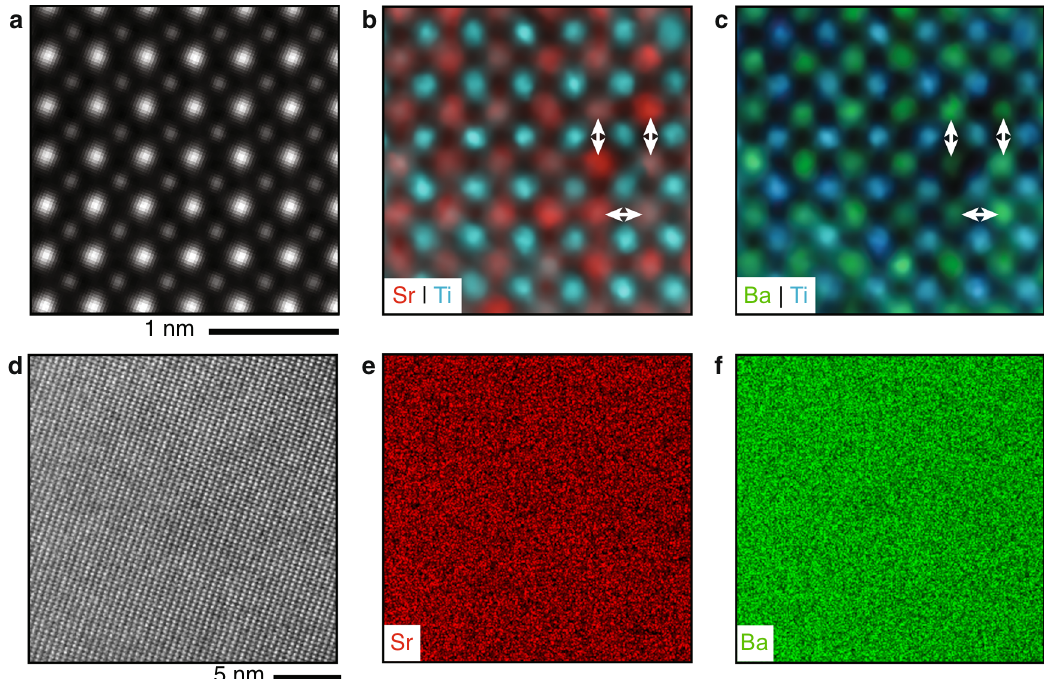
Fig. 3 Nanoscale and atomically resolved chemical analysis of BST6040. a HAADF-STEM image viewed along the [0 0 1] pc zone axis of an ~2 nm region from Fig. 1a. The corresponding EDXS intensity maps of b Sr/Ti and c Ba/Ti. The arrows indicate Sr ( b ) and Ba ( c ) rich (high intensity) and poor (low intensity) columns. d HAADF-STEM image of a sample segment about ~20 × 20 nm 2 in lateral dimensions and corresponding EDXS intensity maps of e Sr- L and f Ba-L lines. The images illustrate chemical homogeneity on several nanometre scale and heterogeneity on unit-cell and column-to-column scale, while the Ba/Sr 60/40 stoichiometry is preserved on all levels (see Supplementary Note